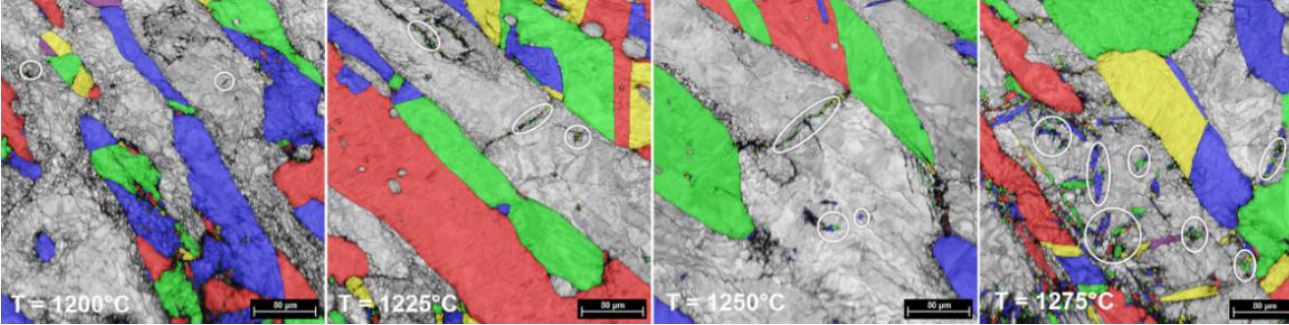
Figure 9. Weight fraction of recrystallized δ-phase ( a ) and precipitated γ 2 -phase ( b ) grains as a function of deformation temperature.